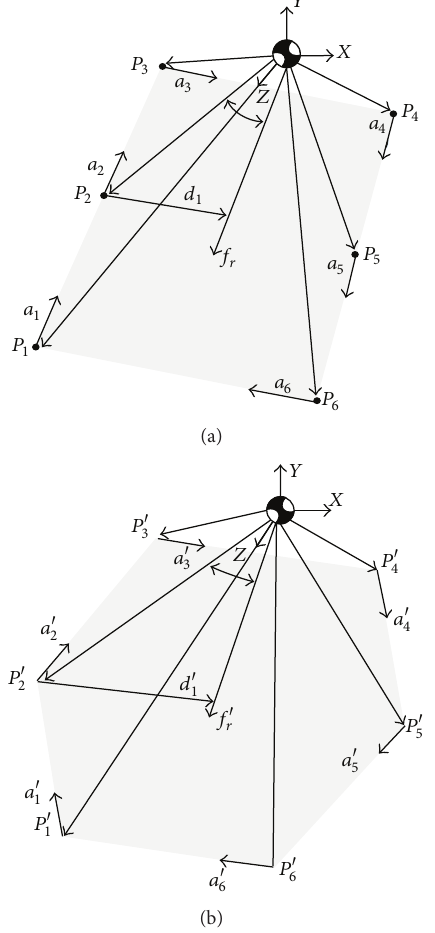
Figure 4: 3D force-angle stability metric: (a) original configuration and (b) high-speed traversal